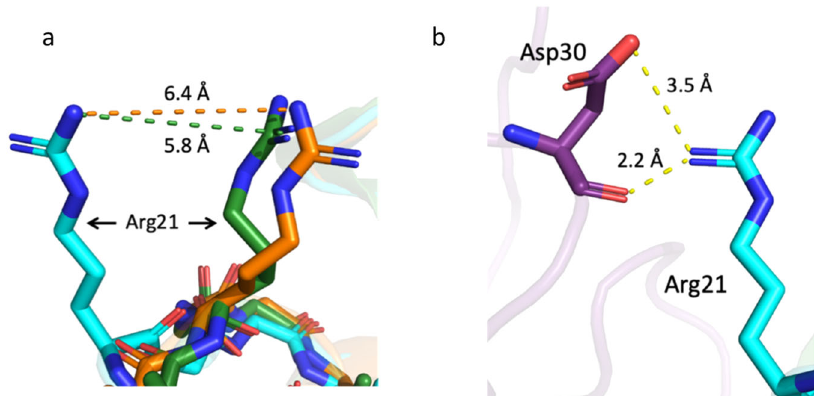
Fig. 7 Comparison of an hArg1 loop when bound to mAb5, mAb1 and small molecule-bound hArg1. An overlay of the hArg1 loop containing residues Lys16-Val24 is shown in Fig. 5d. When bound to the mAb5 antibody, the positioning of this loop (cyan) is altered when compared to hArg1 bound to mAb1 (green) or hArg1 bound to a small molecule (orange). a A closeup of Arg21 in all three structures highlights the difference in orientation of Arg21